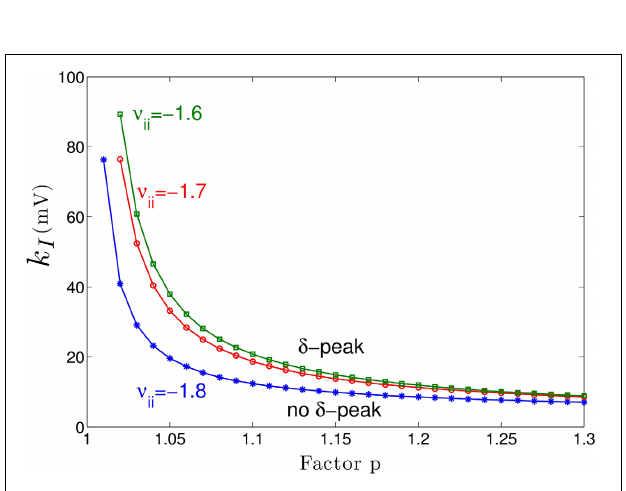
concentration factor is identical in the populations a = E , I and S to (A) and the p = 1 . 125. In addition, the strength of cortical self-inhibition is E = − 1 . 8mVs. ν ii